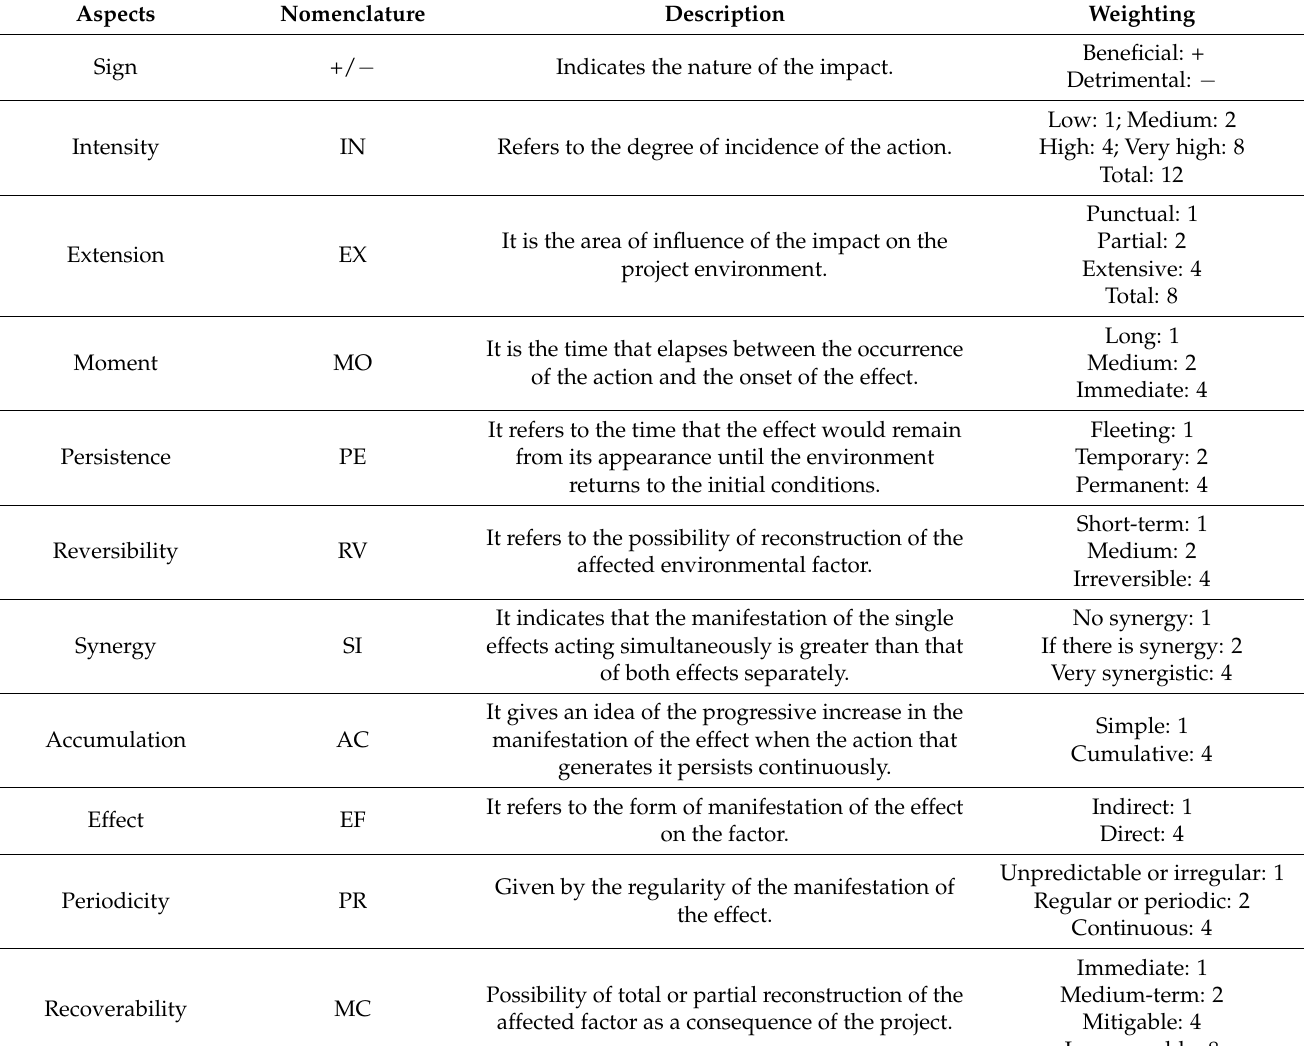
Table 4. Aspects considered in the calculation of the importance of actions performed. Adapted from